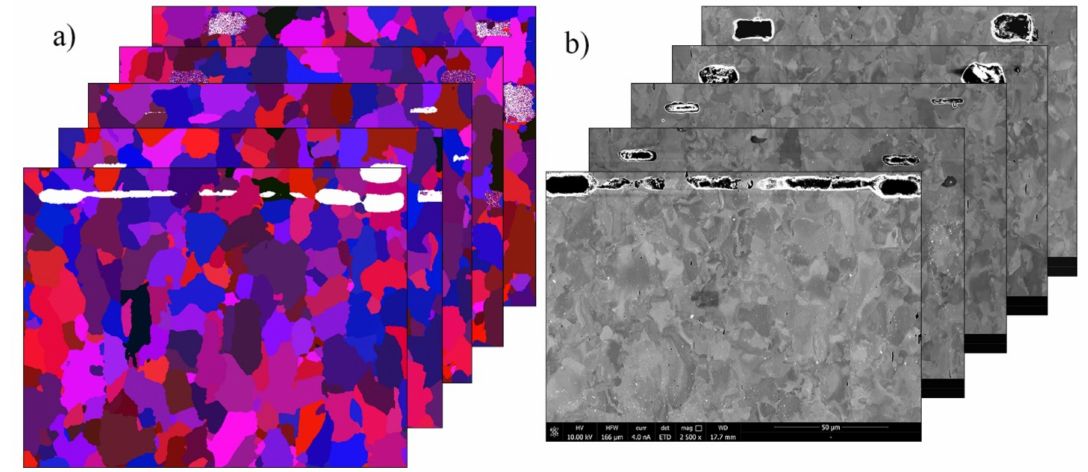
Figure 9. Stack of experimental 2D images of microstructure morphologies obtained via serial sectioning ( a ) EBSD and ( b ) SEM images.